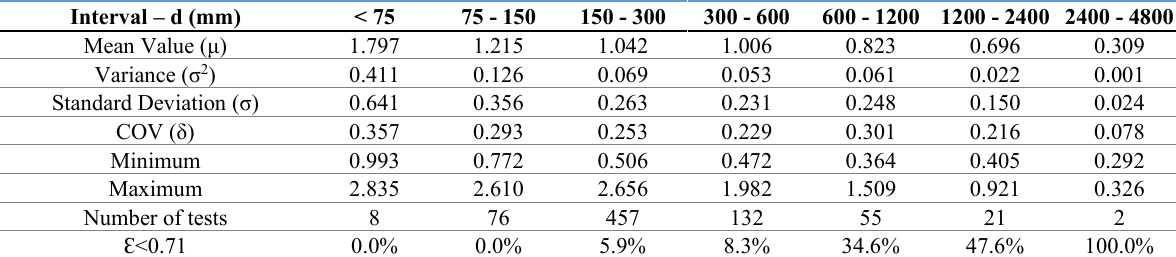
Table 3. Statistics of model error by effective depth range for NBR6118